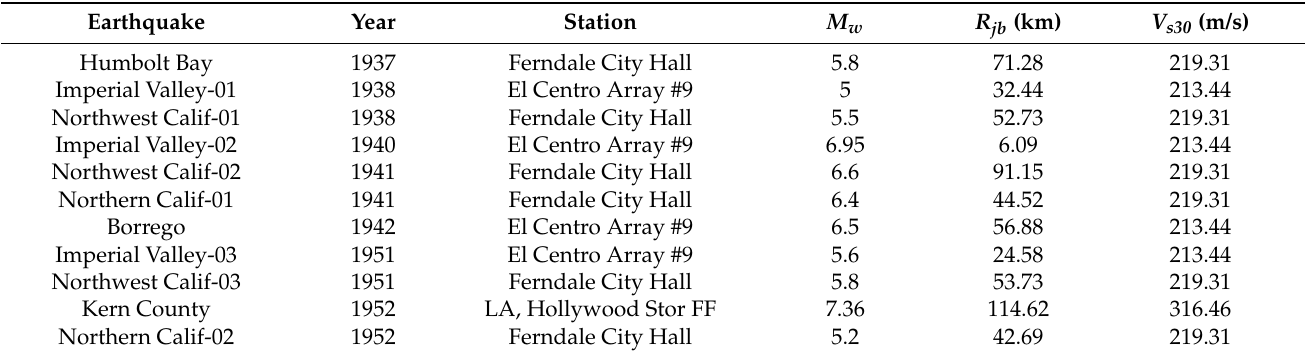
Table 2. Details of ground motions consistent with medium soil.